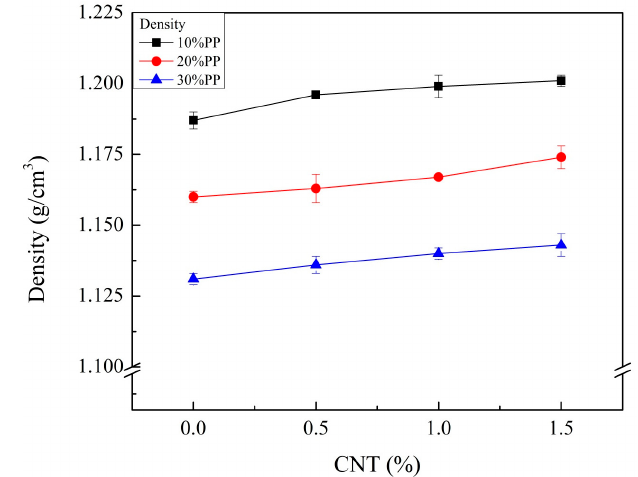
Figure 5. Density results of CF- and CNT-reinforced PA6/PP composites with different PP and CNT compositions.